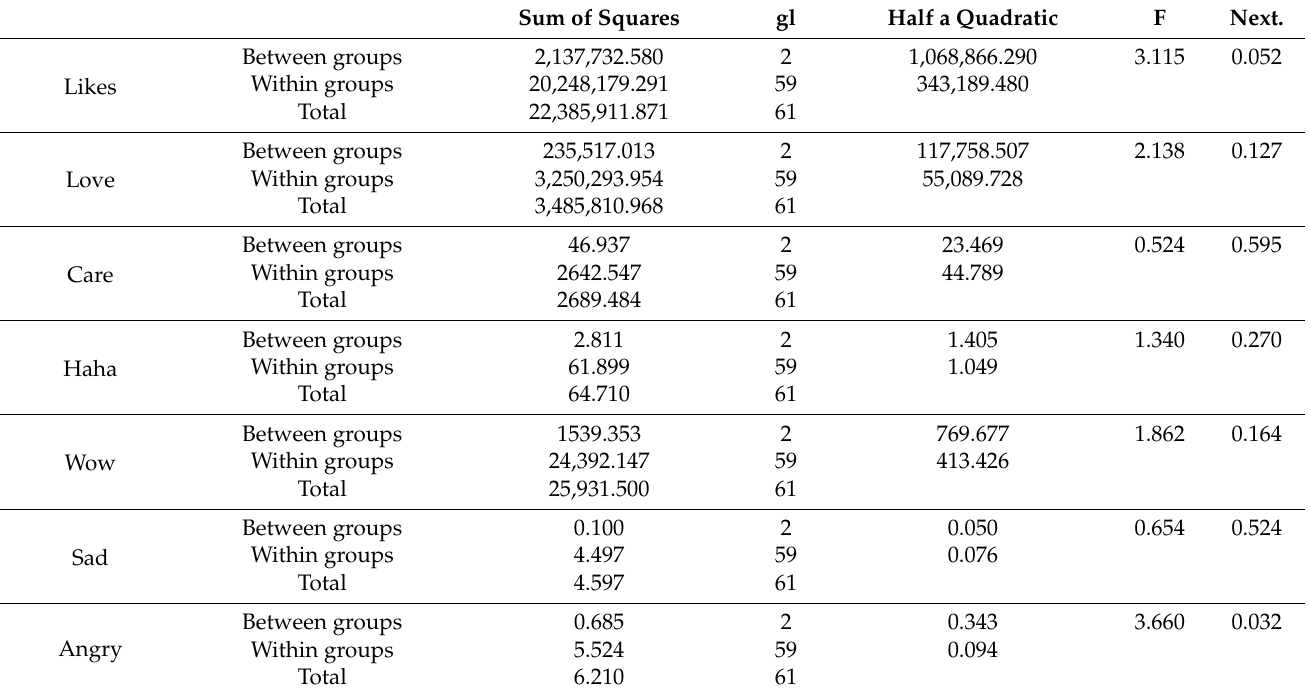
Table 6. ANOVA statistics of feelings according to the brand content. Sum of Squares gl Half a Quadratic F Next.